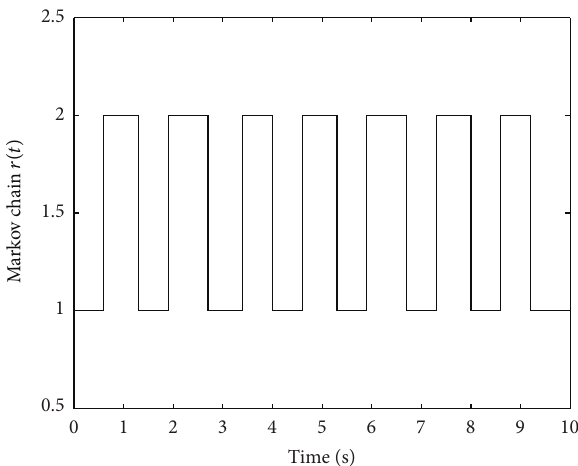
Figure 3: The state 𝑥(𝑡) of the system (23) versus